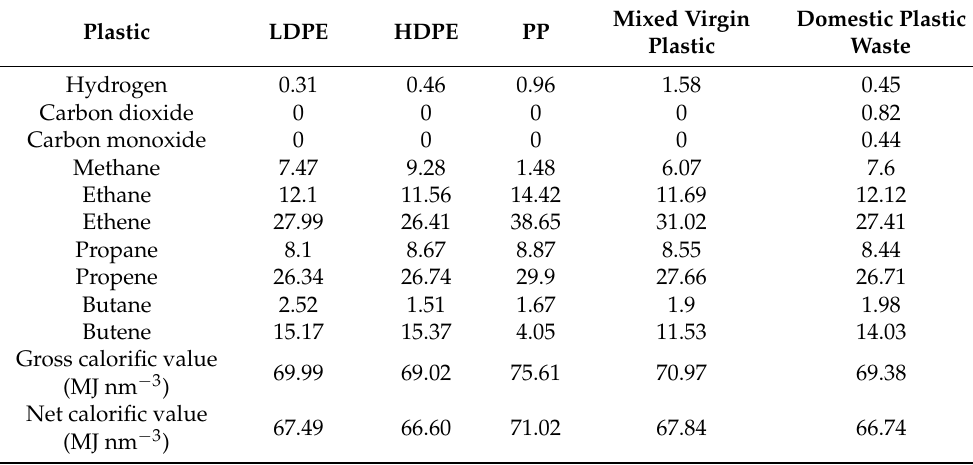
Table 5. Non-condensable gas composition of plastic feedstock